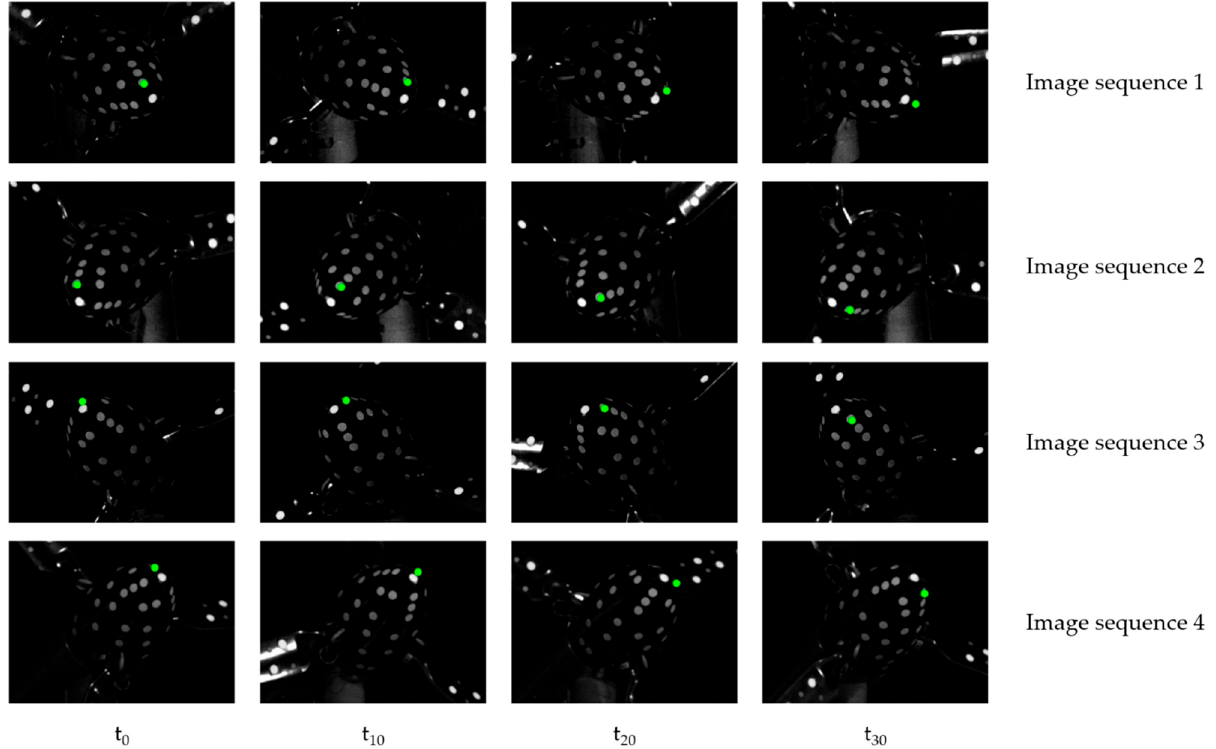
Figure 7. Image sequence: the green point is tracked through four epochs, showing complicated tracking behavior due to occlusions and similarity between uncoded targets.